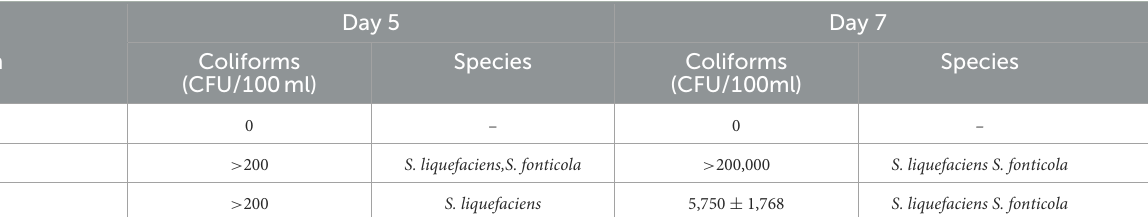
TABLE 4 The amount (CFU/100mL) of coliforms on day five and day seven was determined with